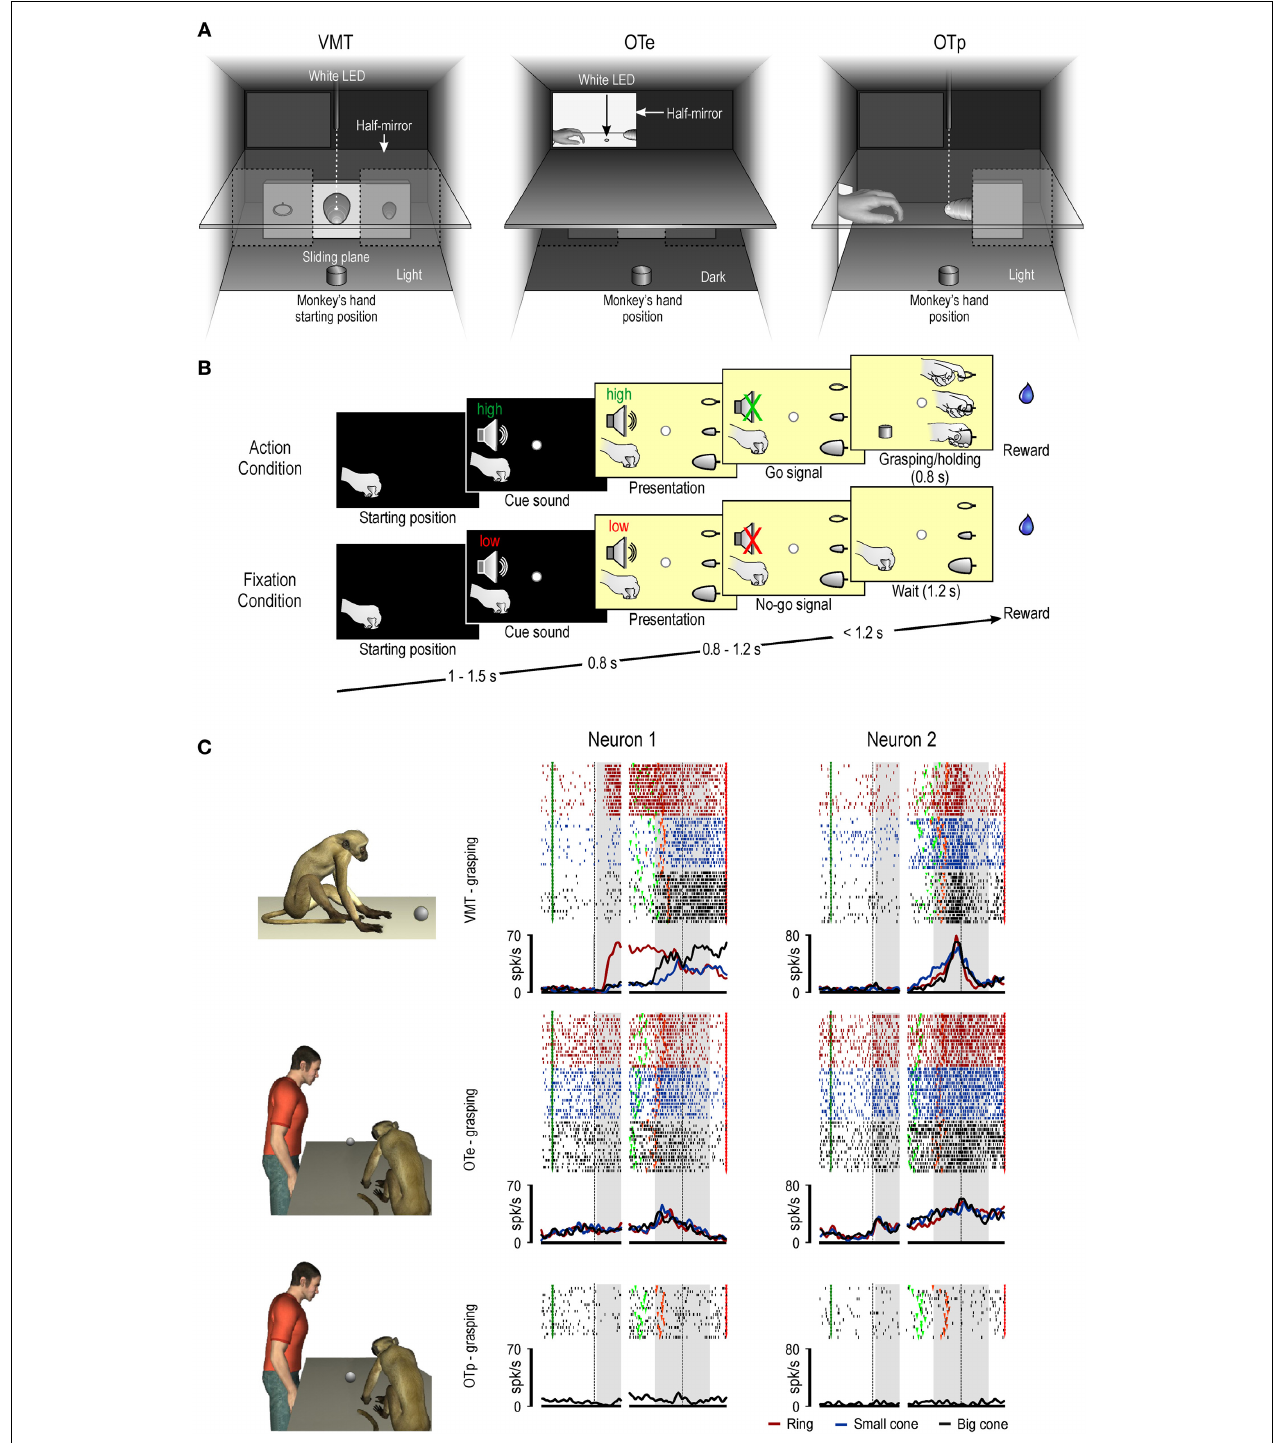
FIGURE 1 | (A) Box and apparatus (seen from the monkey’s point of view) settled for carrying out the visuomotor task (VMT), the observation task in the monkey’s extrapersonal (OTe) and peripersonal (OTp) space. (B) Task phases of Action and Fixation conditions. Each trial started when the monkey had its hand in the starting position. A fixation point was presented and the monkey was required to fixate it for the entire duration of the trial. One of two cue sounds was then presented: a high tone,